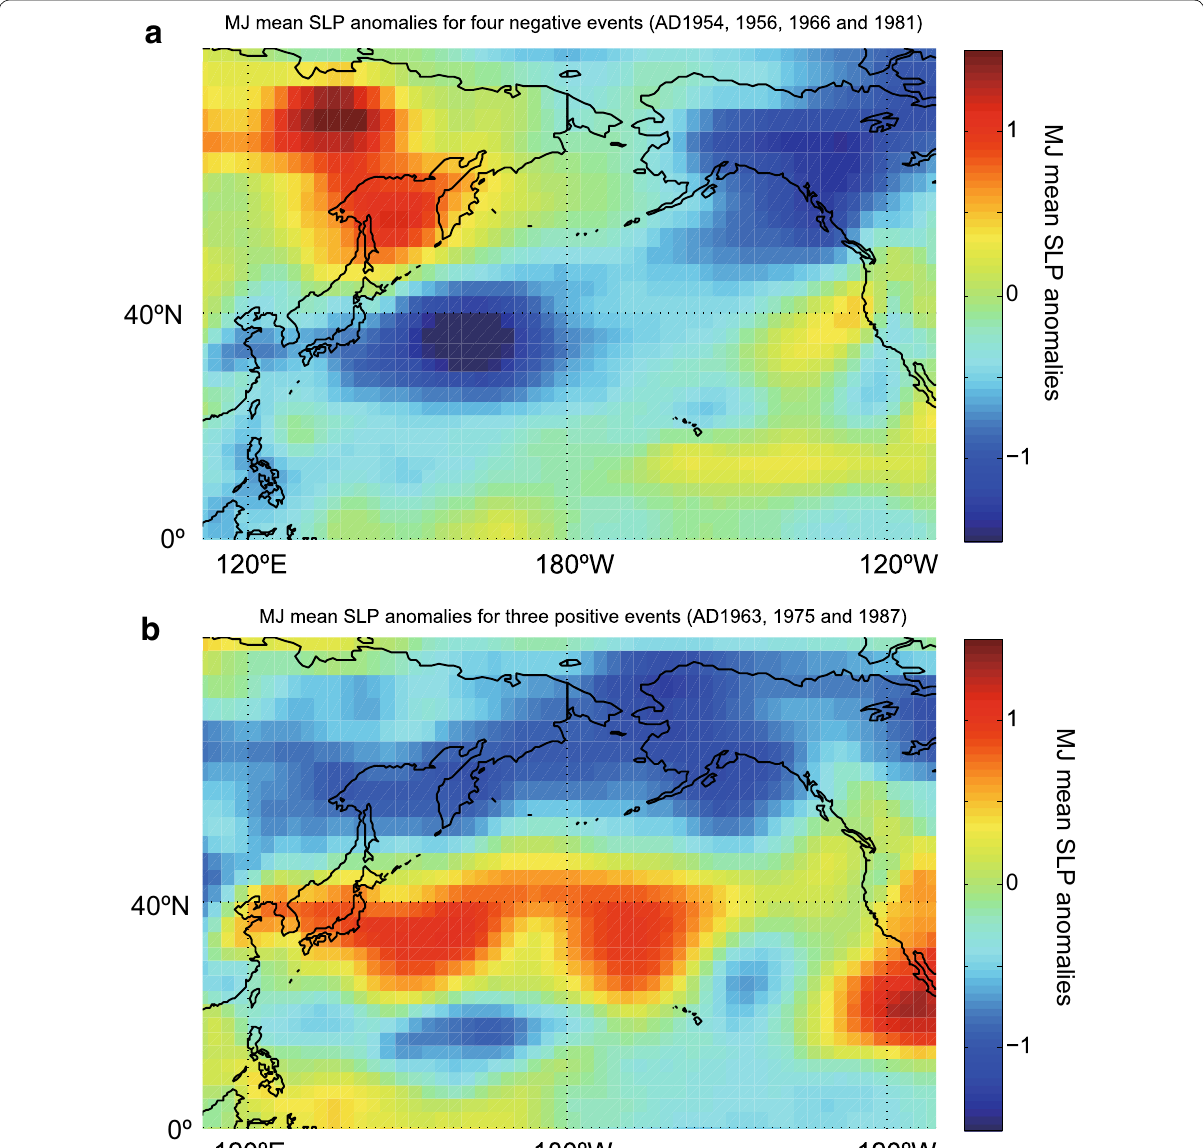
Fig. 7 a MJ mean SLP anomalies for four negative tree-ring cellulose events (A.D. 1954, 1956, 1966 and 1981). b MJ mean SLP anomalies for three positive tree-ring cellulose events (A.D. 1963, 1975, and 1987). Datasets were from NCEP/NCAR reanalysis 1 (Kalnay et al. 1996). These anomalies were normalized to zero mean and one standard deviation during A.D.